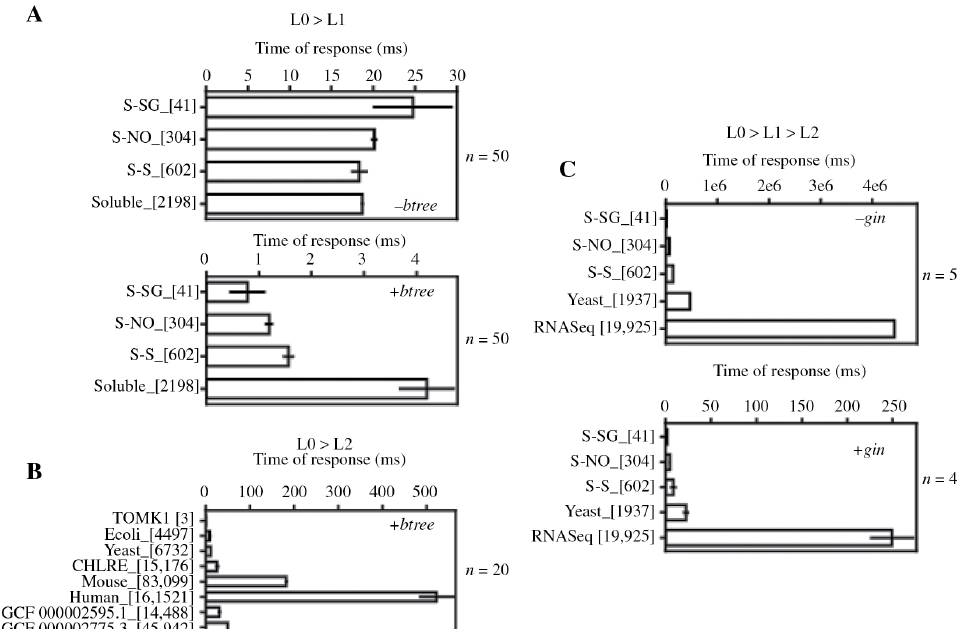
Figure 3: MinOmics querying performances. The speed and efficiency of navigation into the layers of the MinOmics database is measured as the time of transaction for fetching all elements either from experimental datasets through Exp_id (A and C), or organisms datasets through Org_id (B) keys. S-SG stands for glutathionylome, S-NO for nitro- sylome, S-S for reductome and soluble for C. reinhardtii soluble proteome. An adapted indexing strategy allows faster queries (lower panels A and C). Standard error of N tests is indicated and the queryset size is given in between